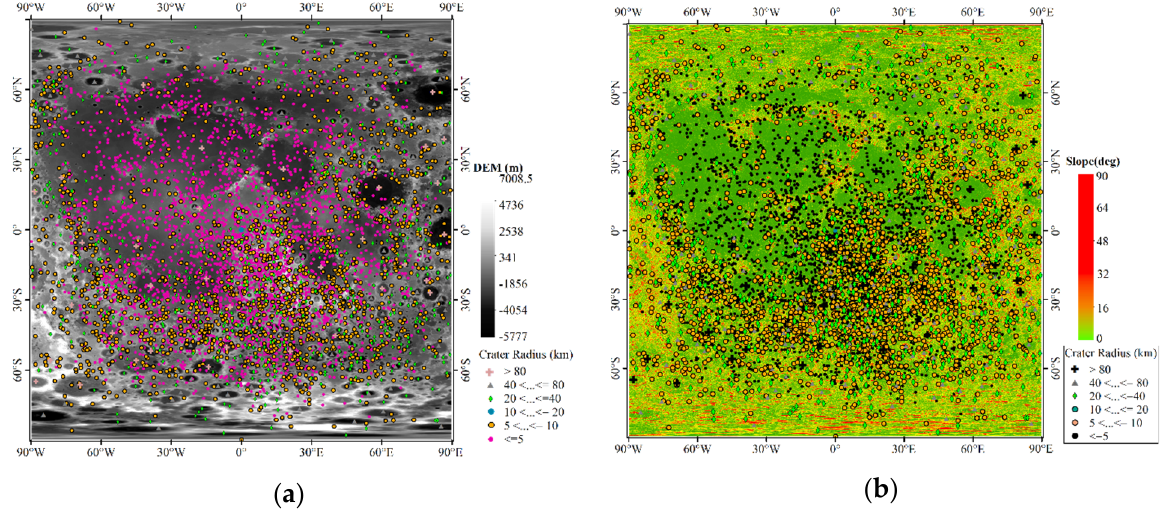
Figure 6. Craters’ distribution on the near side with ( a ) DEM basemap and ( b ) slope basemap. Table 2. The distribution of craters on the near side.